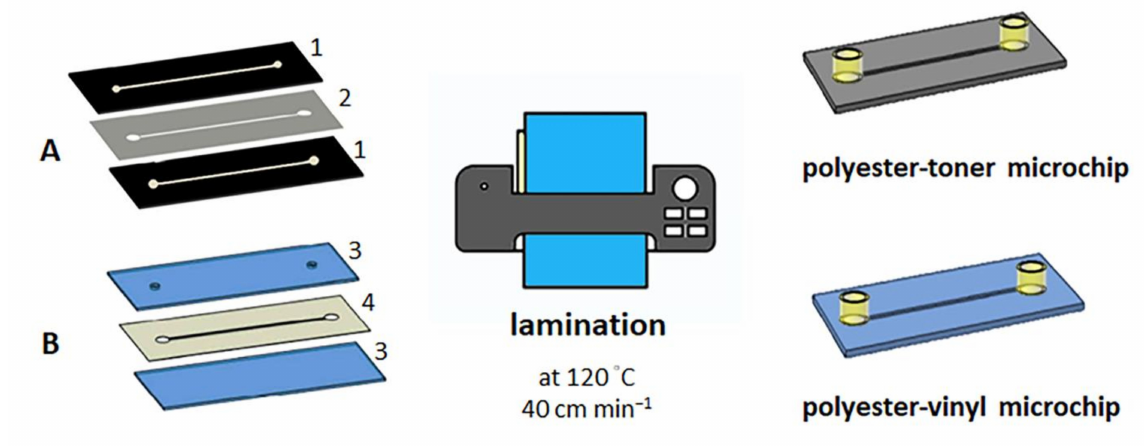
Figure 1. The laminated microchip fabrication is based on using a laminator at 120 ◦ C and 40 cm min − 1 to join the microchip layers. ( A ) PET microchip (the microchannel dimension is 2 × 2 with the cut channel 5 mm × 0.103 mm) consisting of polyester film with channel toner printed in one side (1) and bare polyester film (2). ( B ) polyester-vinyl microchip with bare polyester film (3) and the middle layer is made of three layers of vinyl adhesives with a cut-through channel (4). The top of the microchips contains a female luer glued to facilitate the silicone hose fitting for microfluidic